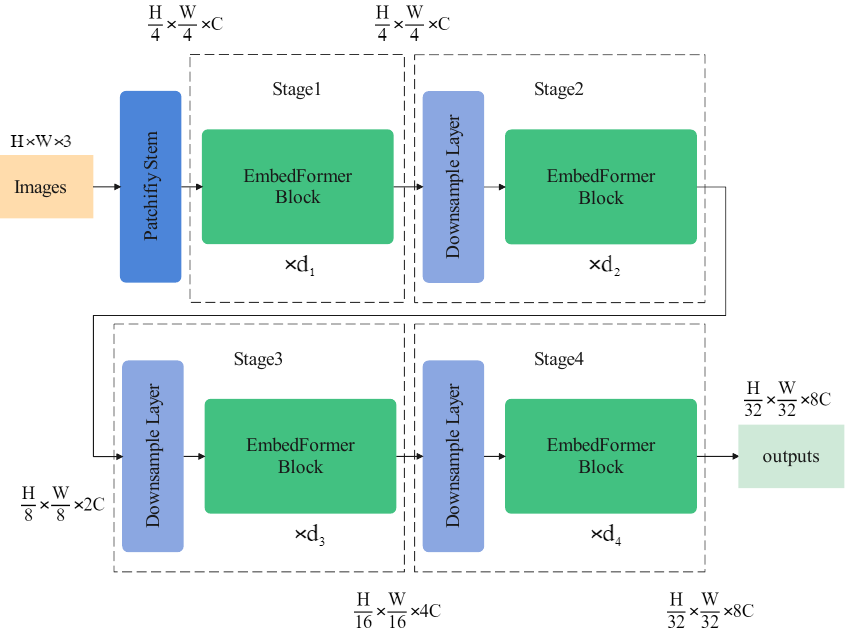
Figure 5. The overall architecture of an